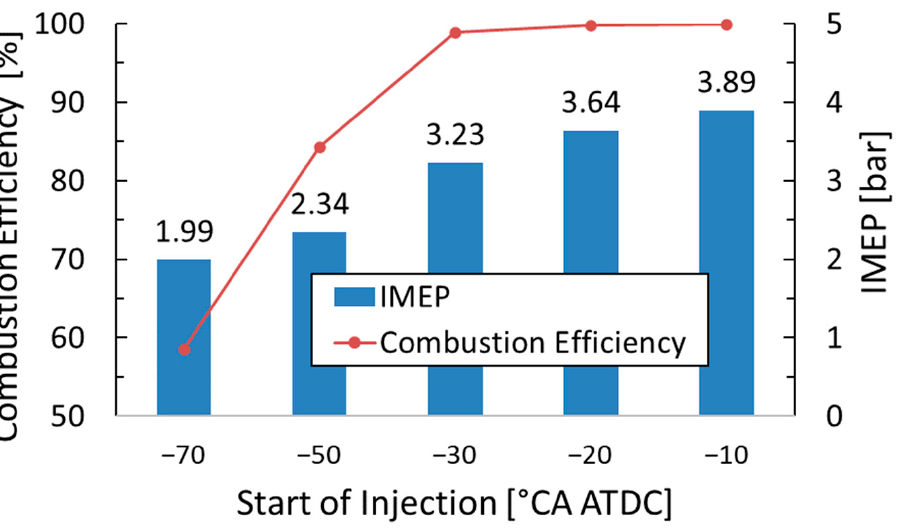
Figure 15. Effect of SOI timing on CE and IMEP. For various SOI timings, evolution of sprays according to °CA after SOI in top and oblique side views are presented in Figure 16.